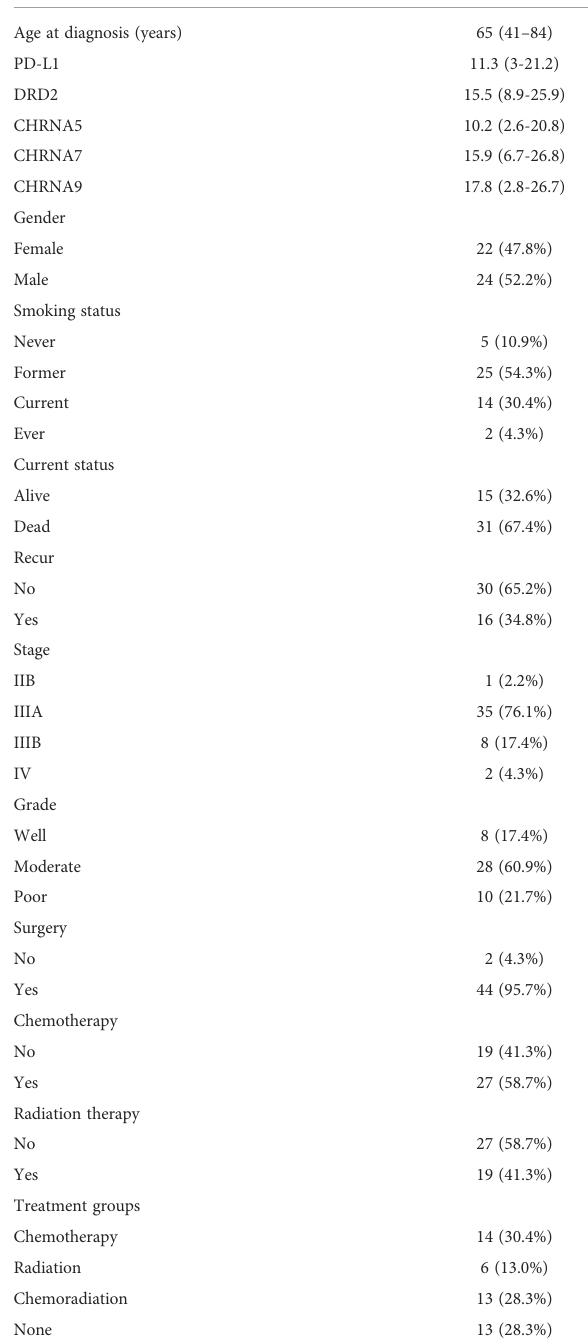
TABLE 1 Patient